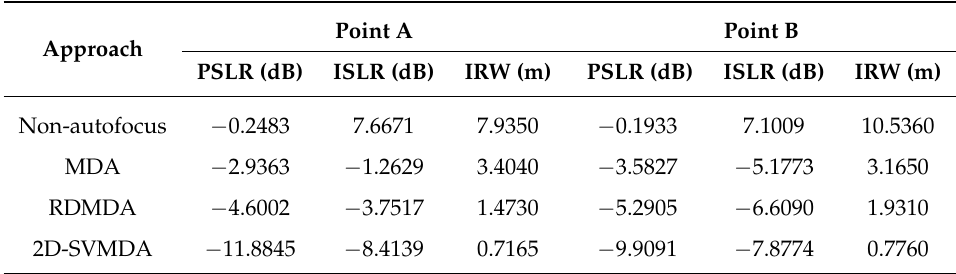
Figure 17. Azimuth impulse response curve comparison of point-like targets. ( a ) Azimuth response of Point A. ( b ) Azimuth response of Point B. Table 9. Statistical focus comparison of Non-autofocus, MDA processed, RDMDA processed and 2D-SVMDA processed Point A and Point